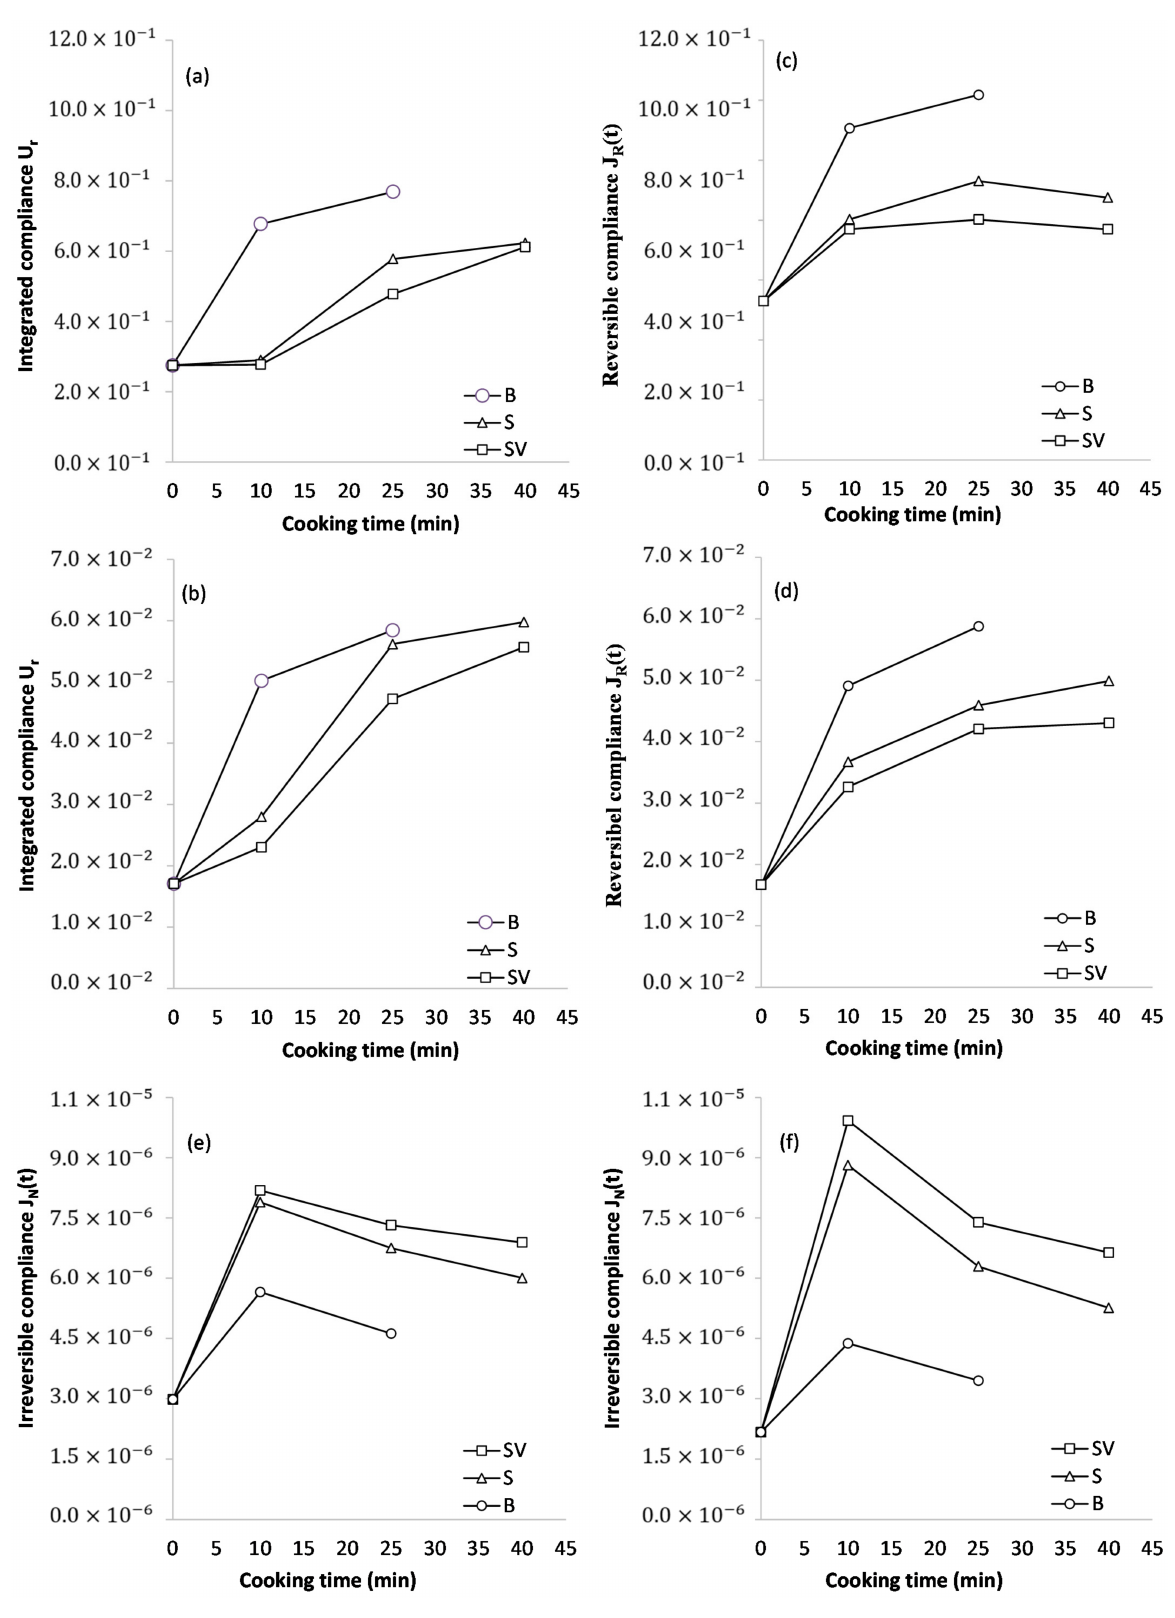
Figure 5. Softening kinetics as described by the integrated compliance U r (t) ( a , b ) as well as of the reversible J R (t) ( c , d ) and irreversible J N (t) ( e , f ) components of the compliance under boiling (B), steaming (S), and sous-vide (SV) for Depurple (left) and Cheddar (right)